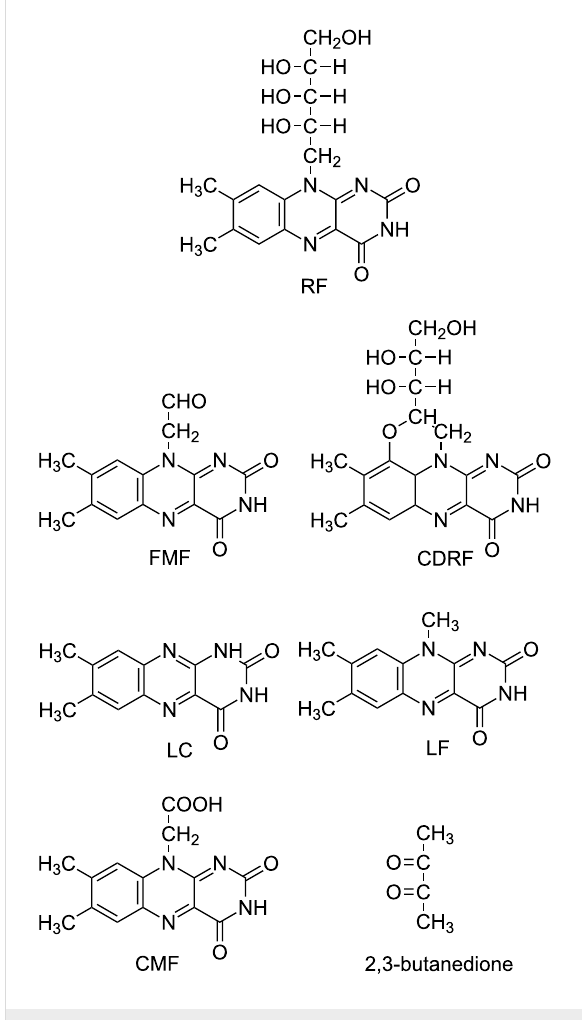
Figure 1: Structures of RF and its